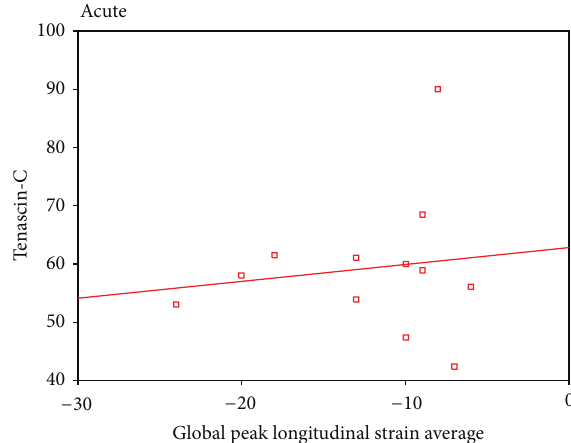
Figure4:Asignificantpositivecorrelationbetweenserumtenascin- c and global peak longitudinal strain average in group I.